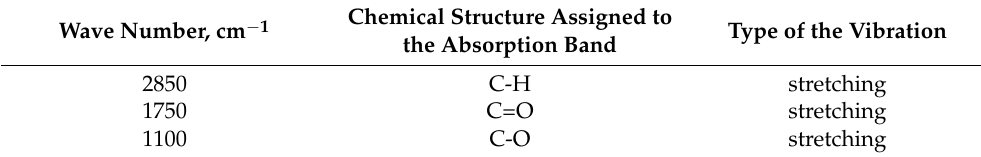
Table 2. The absorption bands observed on FT-IR spectra of hydrogels before and after the incubation studies.